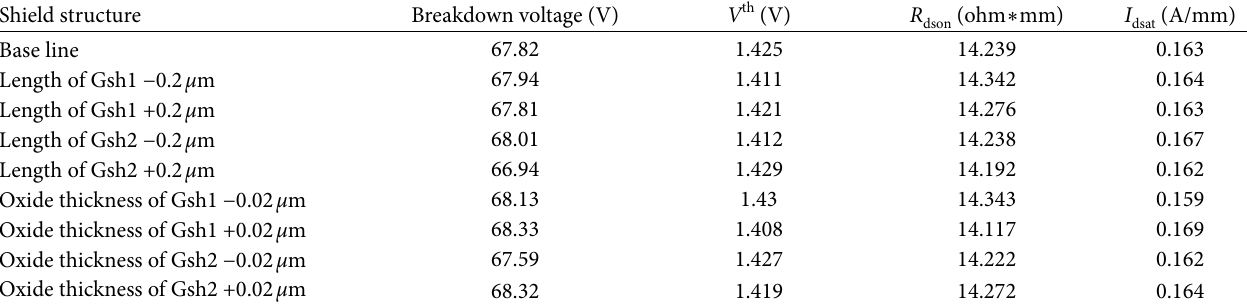
Table 2: DC data from test